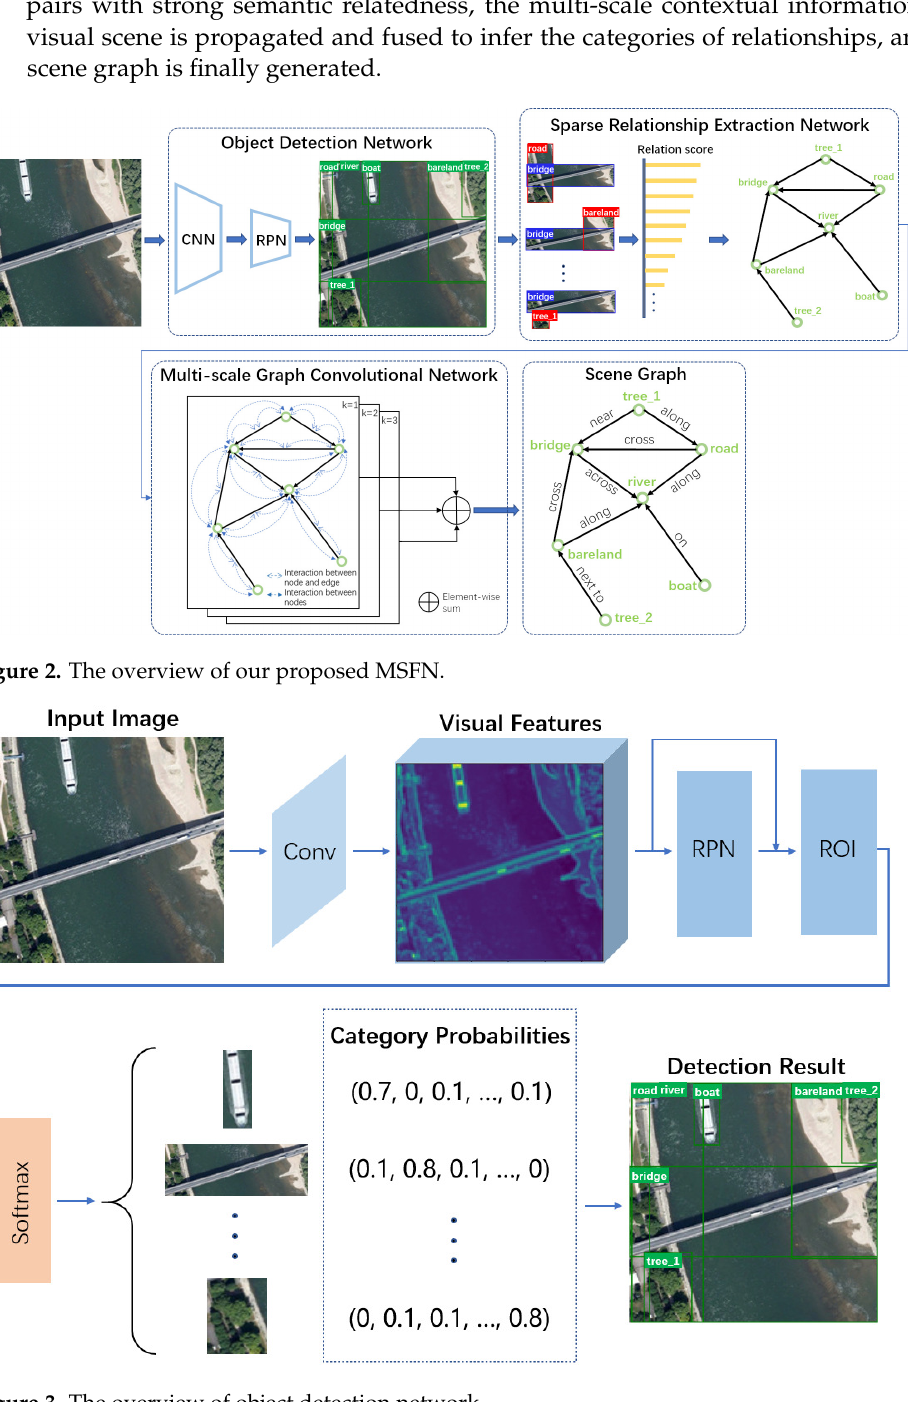
Figure 3. The overview of object detection